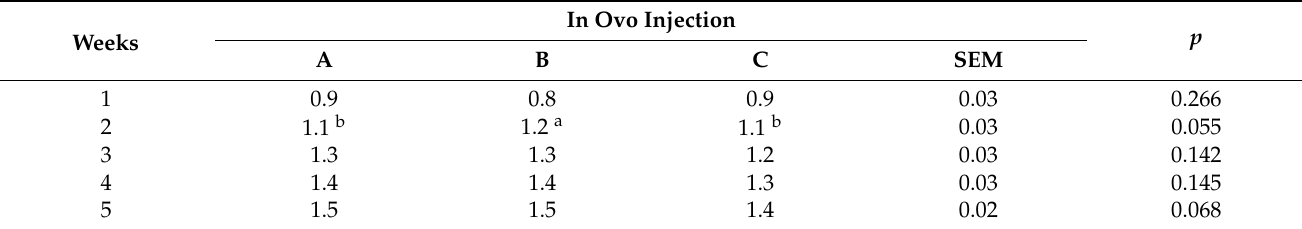
Table 5. The effects of in ovo injection of vitamin C on the feed–conversion ratio.